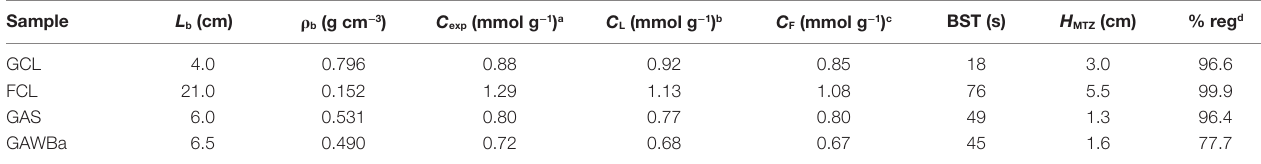
TaBle 4 | experimental parameters for breakthrough curves and comparison between experimental cO 2 capacities (0.4 g of adsorbent, 25°c, 101.3 kPa, 15% cO 2 in n 2 ) and langmuir and Freundlich models predictions (25°c, pure cO 2 , 15.2 kPa).